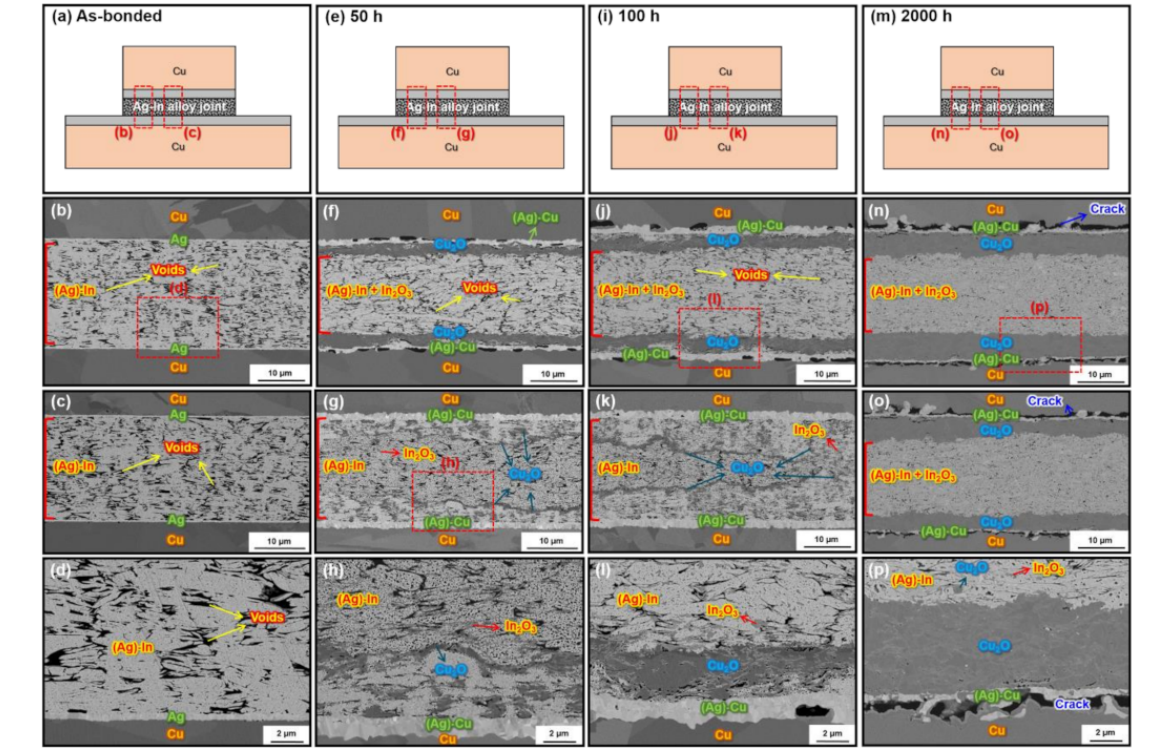
Figure 9. SEM images of the cross-section microstructure of the sintered Ag–In alloy joints bonded at 10 MPa after HTS at 300 ◦ C. ( a , e , i , m ) Schematics of the cross-section of the Ag–In alloy joints as-bonded and after HTS for 50 h, 100 h, and 2000 h, respectively. The dashed boxes in ( a , e , i ), and ( m ) indicate the regions near the edge shown in ( b , f , j ), and ( n ), as well as the regions away from the edge shown in ( c , g , k ), and ( o ), respectively. Zoomed-in images of the regions indicated in ( b , g , j ) and ( n ) are shown in ( d , h , l ), and ( p ),